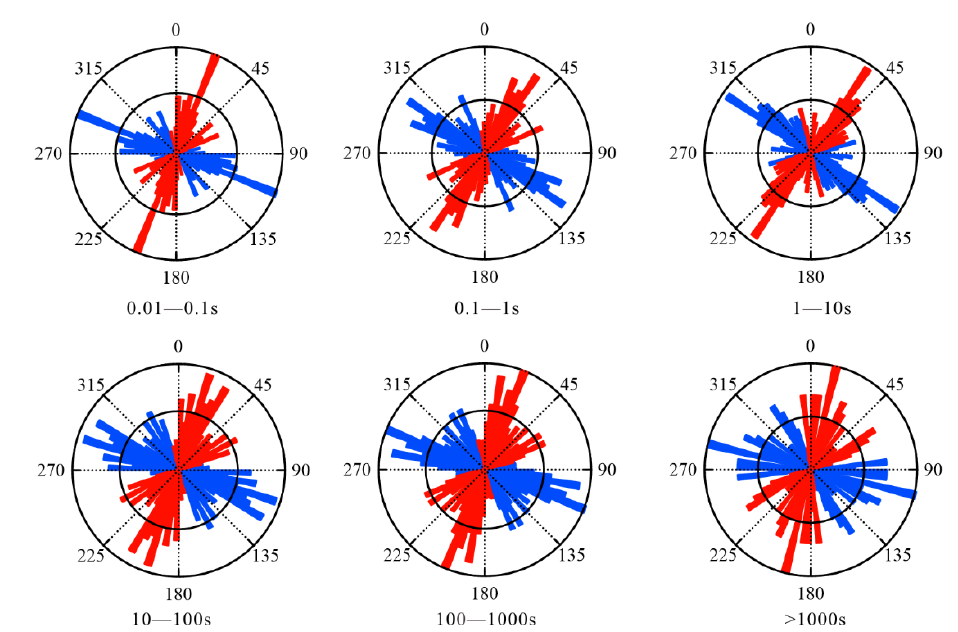
Figure 5. Rose diagrams of structural strike analysis in different periods (the red shows the calculated direction of the electrical strike; the blue shows the ambiguity of 90°).